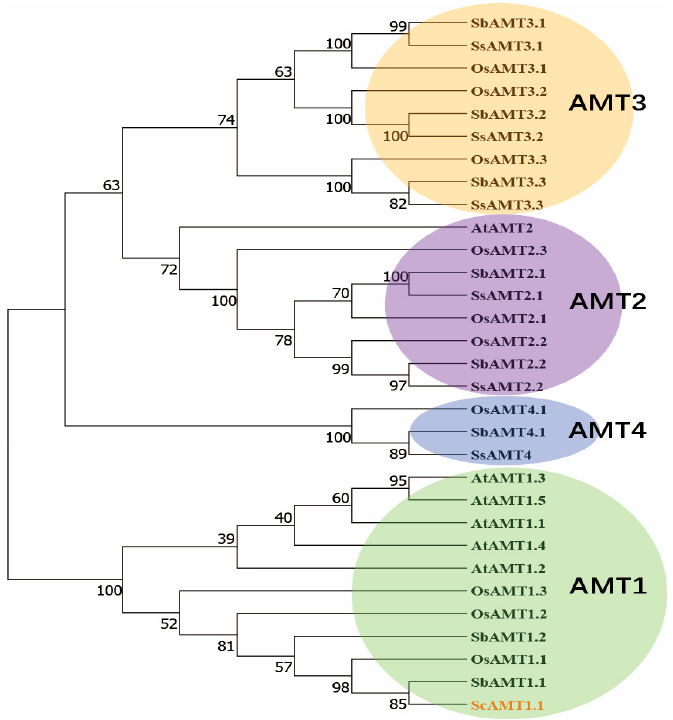
Figure 3. Phylogenetic relationship of sugarcane ScAMT1.1 protein and AMTs from S. spontaneum